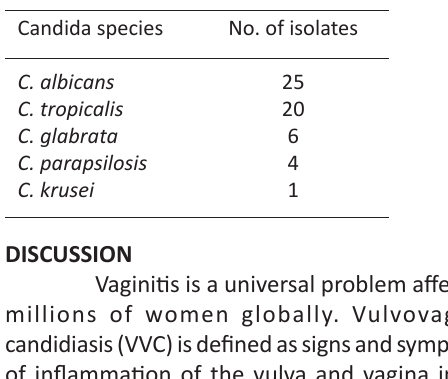
Table 3. Species distribution of candida